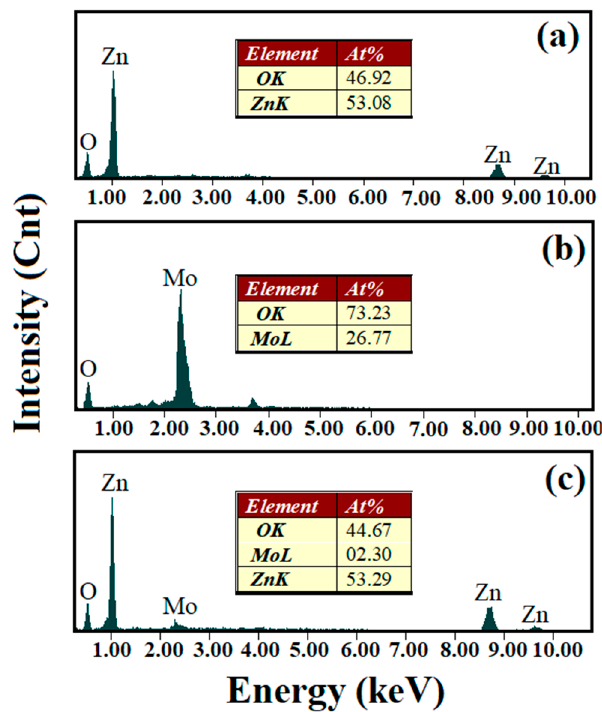
Figure 3. EDX spectra of pure ZnO ( a ), MoO3 ( b ) and ZnO:MoO3 (S5) ( c ) nanostructures.